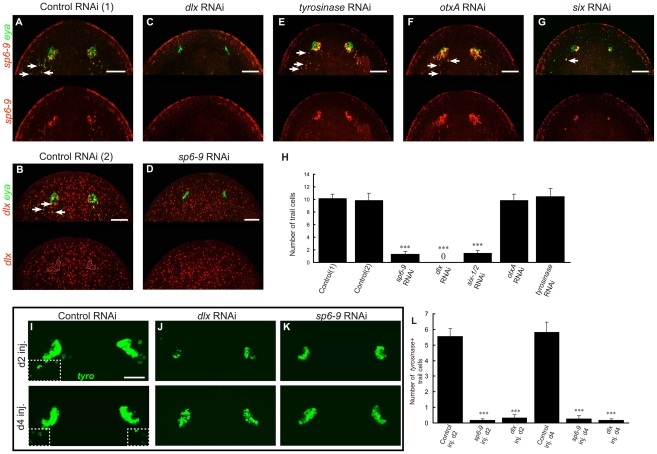

dlx and sp6-9 are required for regenerative optic cup cells.All fluorescence is FISH. Day 7 regeneration blastemas are shown, anterior is up. (A–G) Photoreceptor defects following RNAi of eye-expressed genes. Control RNAi animals have co-localization of (A) sp6-9 with eya, or (B) dlx with eya in the eyes and progenitor trail, n = 10/10 animals for each. (C), dlx(RNAi) animals do not regenerate sp6-9+/eya+ cells, n = 10/10. (D) sp6-9(RNAi) animals do not regenerate dlx+/eya+ cells, n = 10/10. (E–F) tyrosinase(RNAi) and otxA(RNAi) animals are able to regenerate sp6-9+/eya+ cells. (G) six-1/2(RNAi) regenerate greatly reduced numbers of sp6-9+/eya+ cells. (H) Quantification of the number of optic cup trail cells for RNAi conditions in (A–G). For control(2) and sp6-9 RNAi, dlx and eya coexpression is used to count trail cells. For all other conditions sp6-9 and eya coexpression is used. (I–K) RNAi of sp6-9 and dlx beginning on either day 2 or day 4 of regeneration results in smaller pigment cups and fewer terminal trail cells, assessed by tyrosinase expression. Boxes with dashed outline in (I) enclose terminal trail cells. (L) Quantification of number of tyrosinase
+ trail cells in the indicated RNAi conditions. Arrows indicate double positive cells. Scale bars, 50 µm.